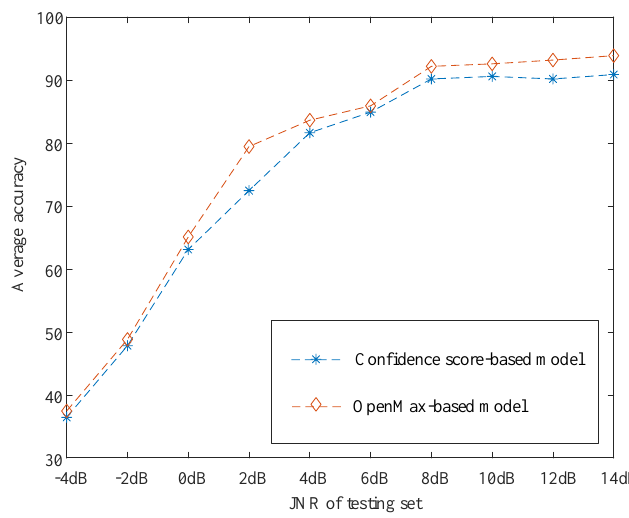
Figure 19. Average accuracy under different JNRs.